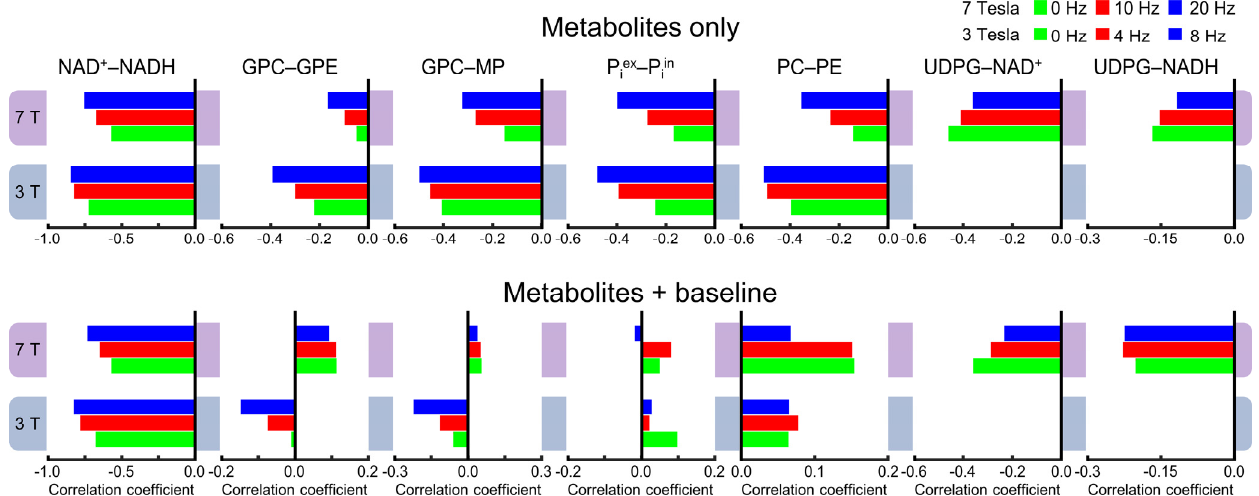
Figure 5. Mean cross-correlation coefficients with metabolites only (top row) and with metabolites + baseline (bottom row) derived from Monte Carlo analysis. Three different line-broadening factors of 0, 4, and 8 Hz for 3 Tesla and 0, 10, and 20 Hz for 7 Tesla were applied. A secondary effect of line-broadening is degraded measurement precision. Tables 1 and 2